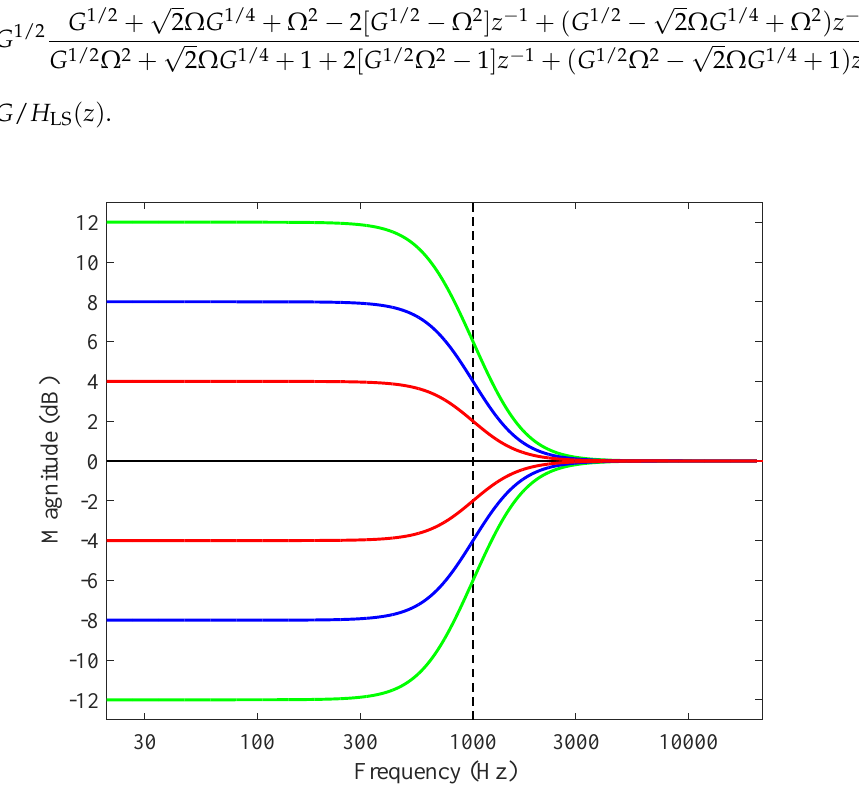
Figure 3. Magnitude responses of second order low shelving filters with complementary gains: ± 12dB (green), ± 8dB (blue), and ± 4dB (red). The vertical dashed line indicates the crossover frequency (1kHz). Cf. Figure